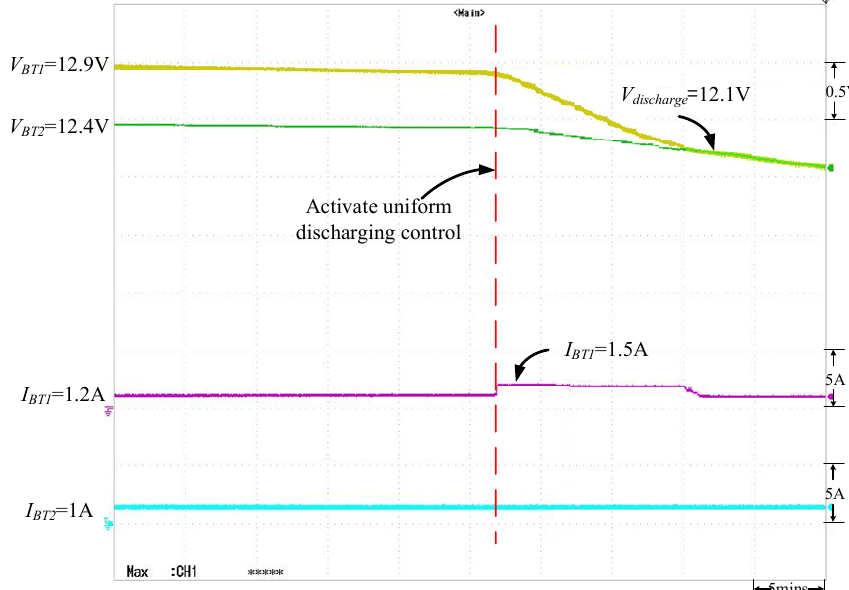
Figure 12. When V BT 1 = 12.9 V, V BT 2 = 12.4 V, uniform discharge control response.